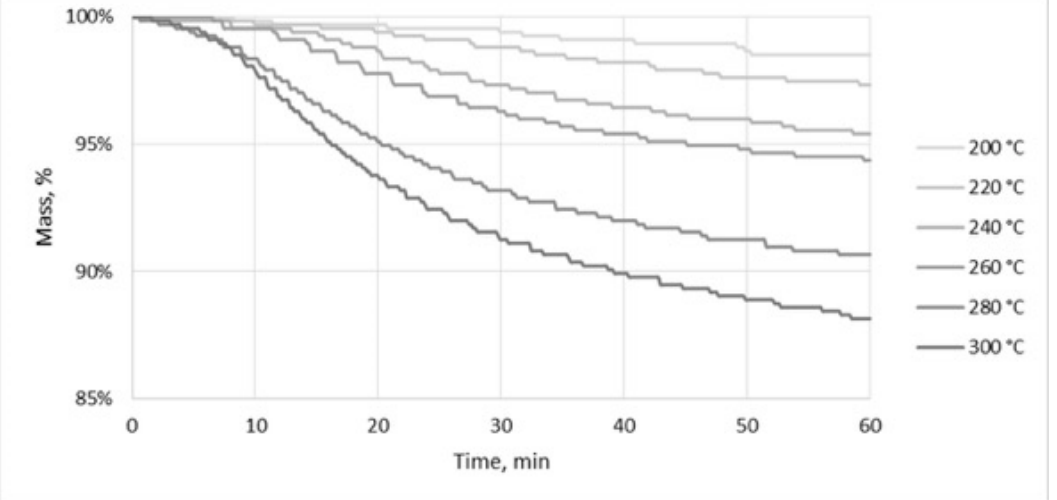
Table 1. Summary of kinetic parameters of the torrefaction process.